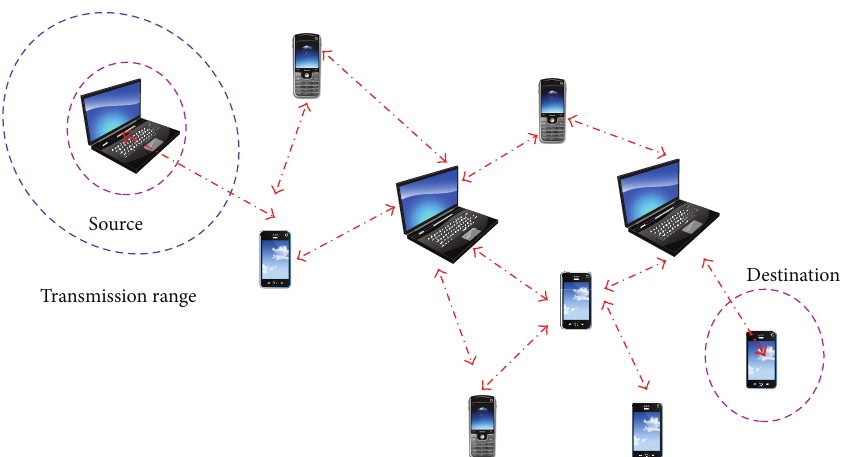
Figure 1: Mobile Ad Hoc